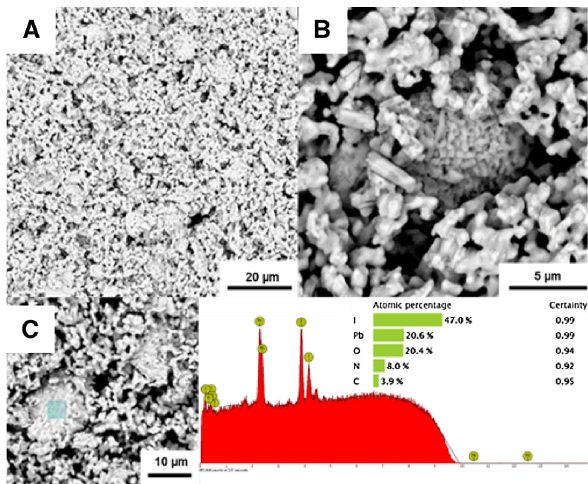
Fig. 5 SEM images and EDX spectrum of the degraded regions in the perovskite film stored at RH 70 % for 70 days, a at 20 l m scale, and b at 5 l m scale, and c EDX spectrum acquired in a square area of image c , scale bar is 10 l m